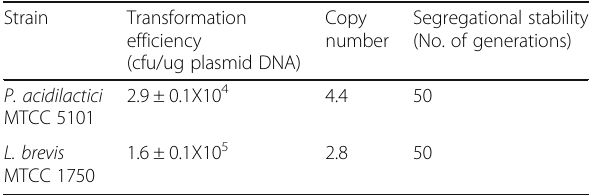
Table 3 Transformation efficiency, copy number,